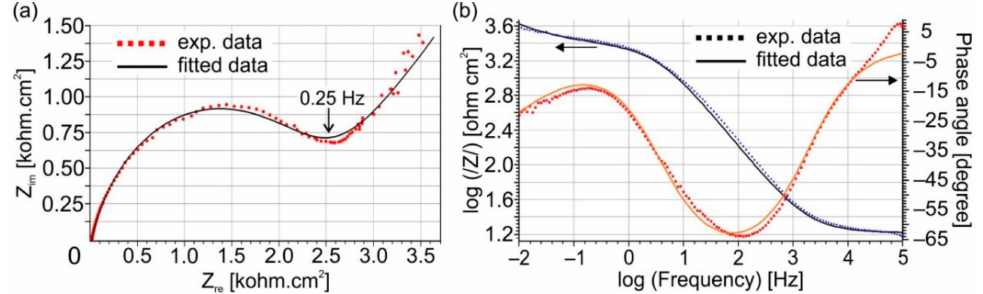
Figure 8. ( a ) Nyquist and ( b ) Bode plots of uncoated copper substrate in 3.5 wt.% aqueous solution